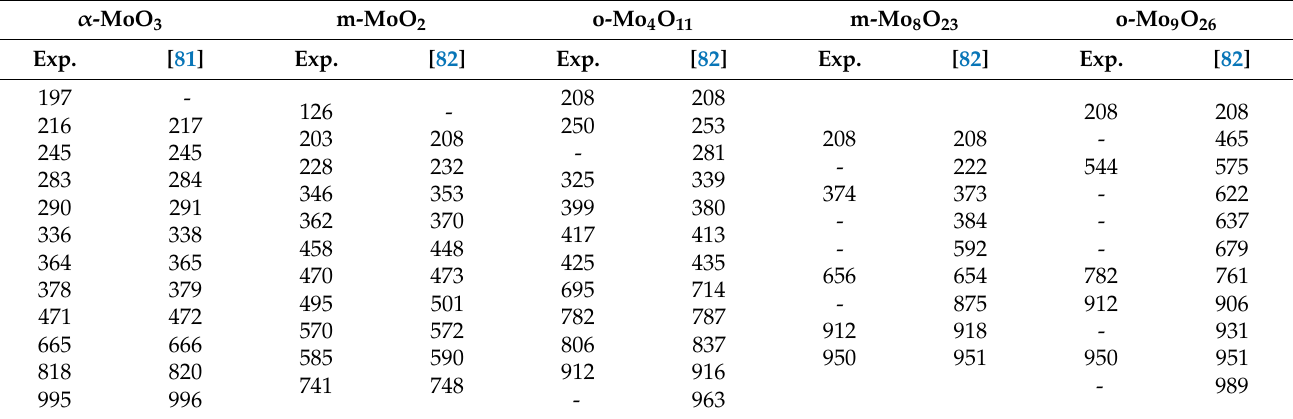
Table 2. Reported Raman peak frequencies (cm − 1 ) of M–O oxides.